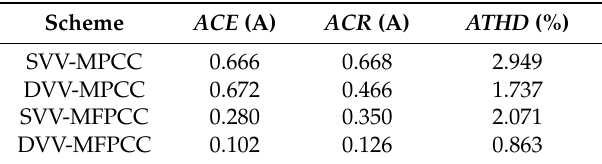
Table 7. ACE , ACR , and ATHD of the four schemes obtained from Figures 12–15.